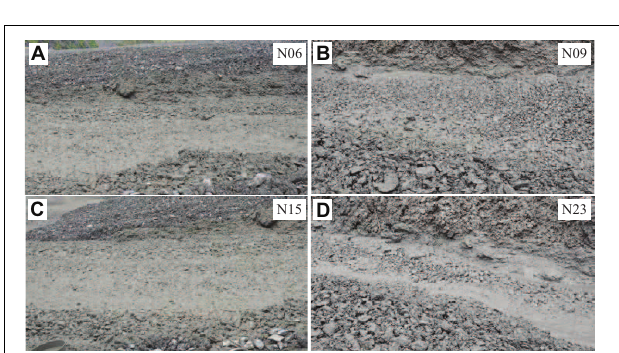
FIGURE 2 | Flow regime of partial